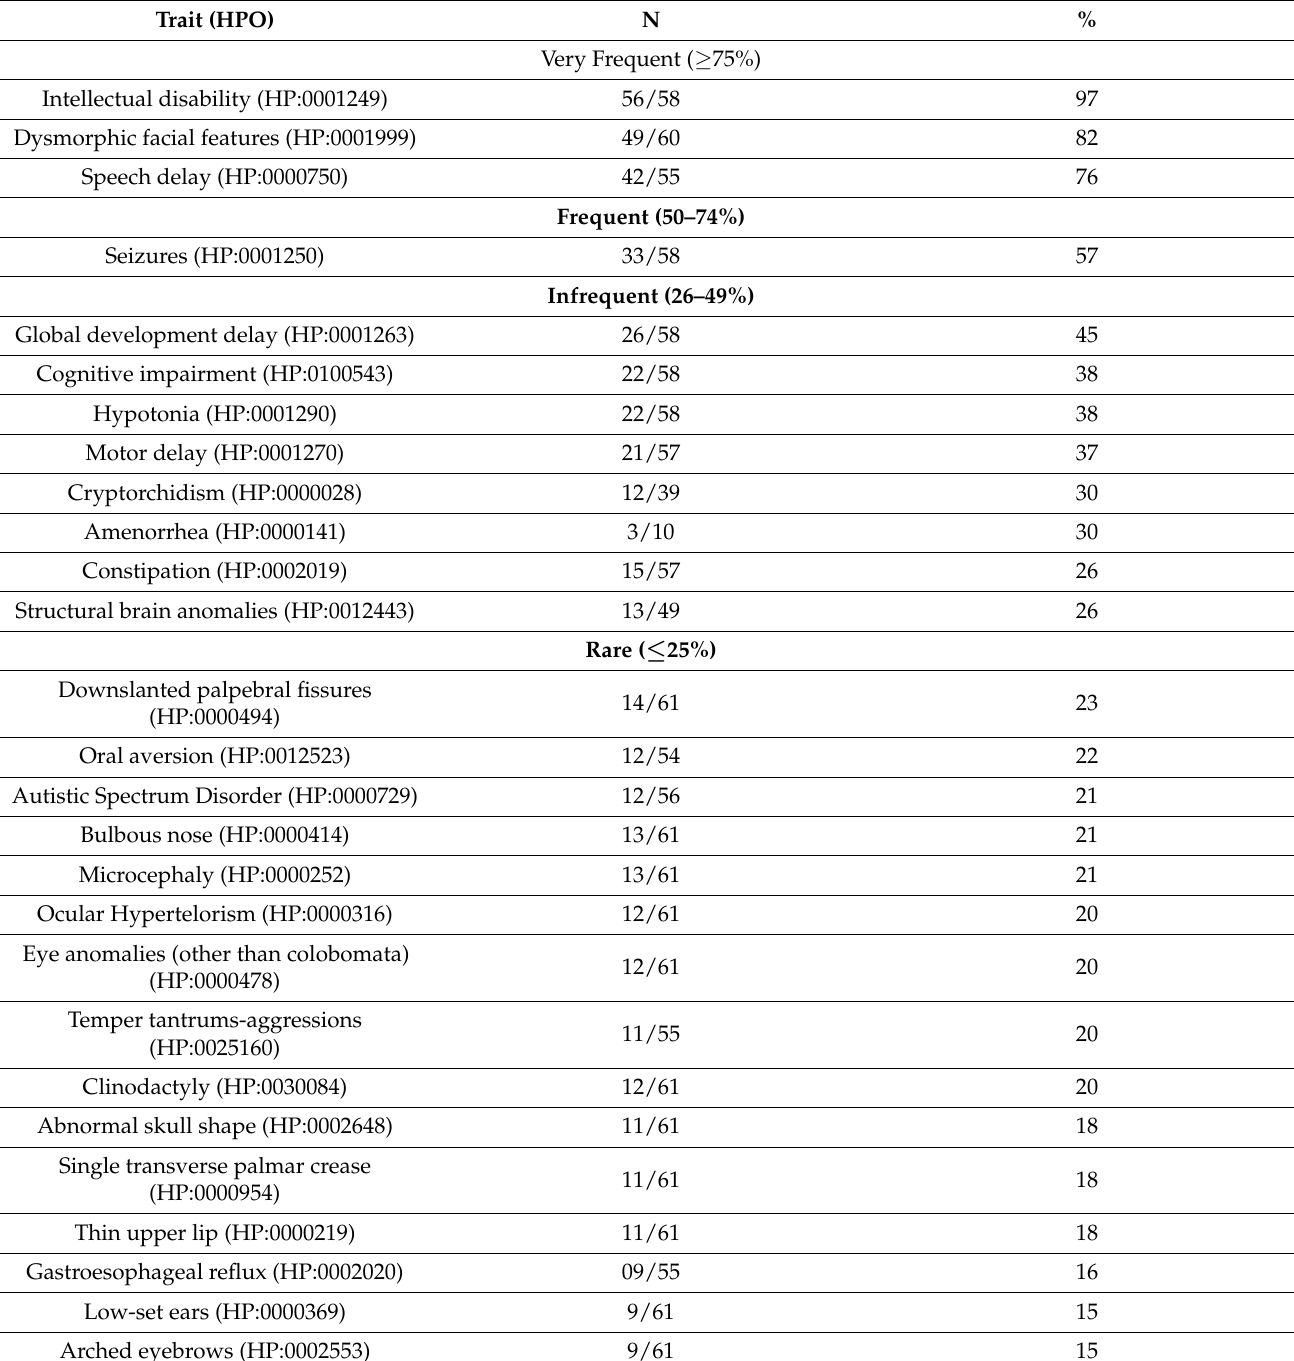
Table 1. Summary of the clinical features of 61 patients (37 males and 24 females) with SHMS/ PACS1 Neurodevelopmental disorder included in this paper. Clinical features are organized according to the HPO nomenclature and grouped in very frequent ( ≥ 75% of patients), frequent (50–74%), infrequent (26–49%) and rare (less than ≤ 25%) findings. In total, 58 patients were diagnosed after birth and three